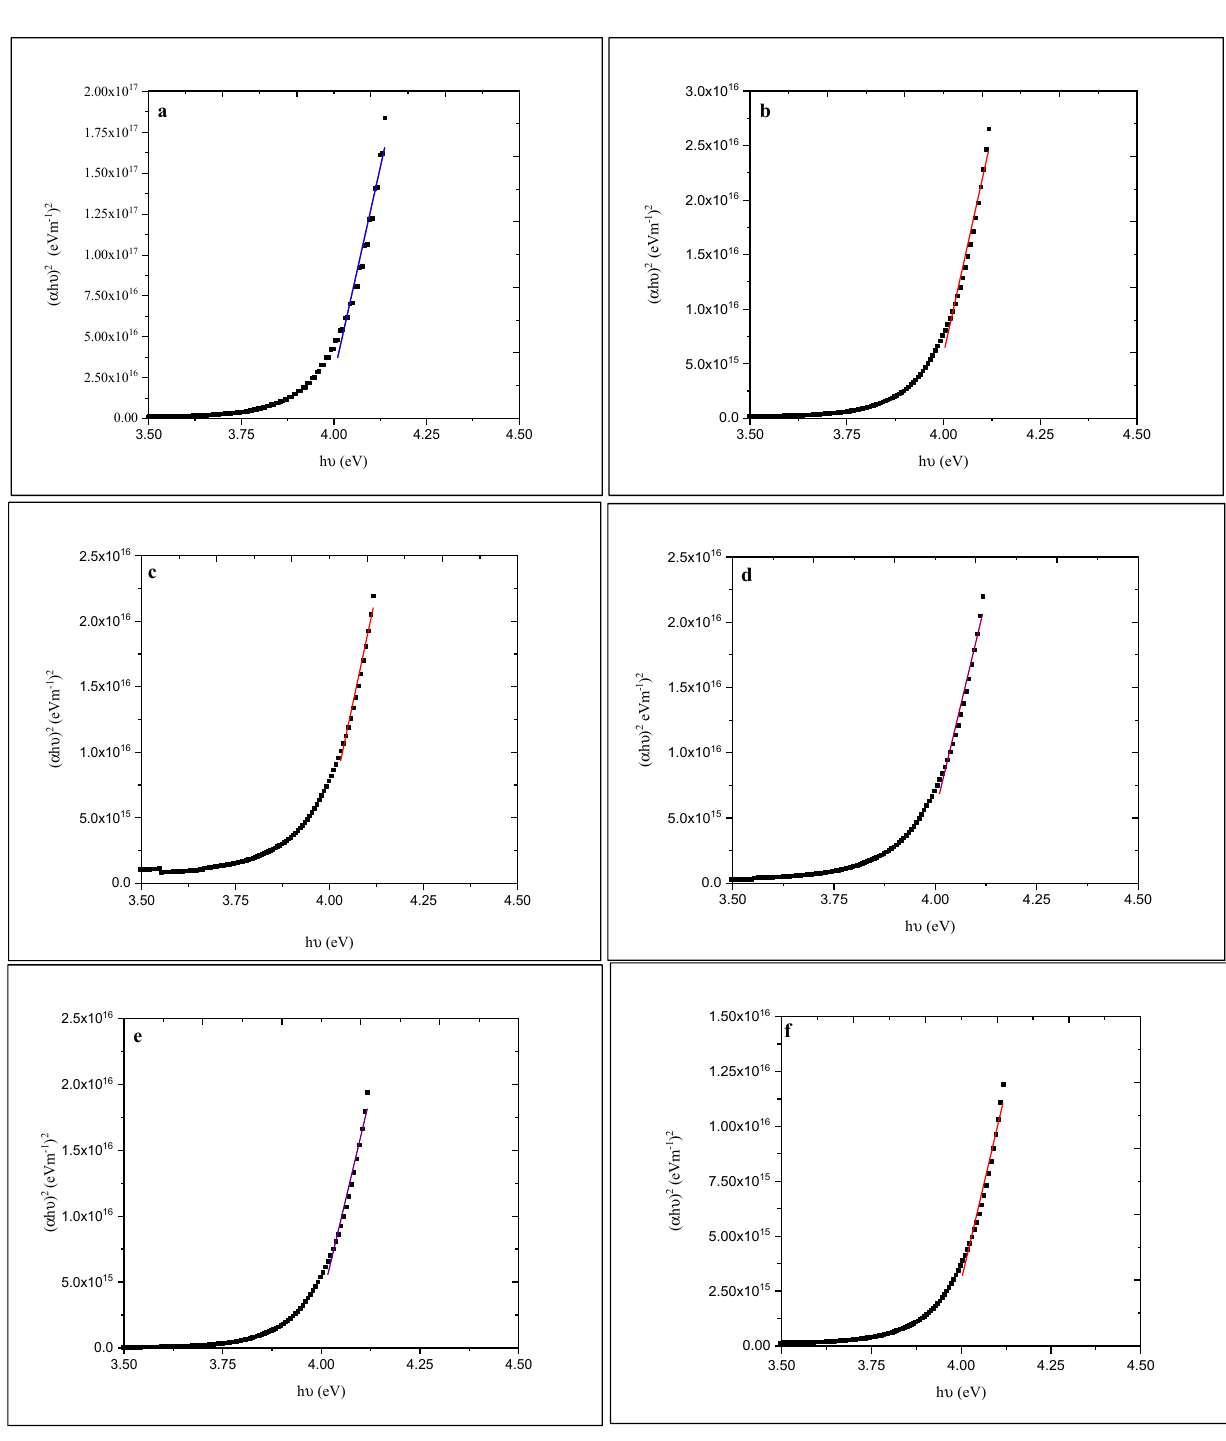
Figure 7. Plots of ( α h υ ) 2 versus h υ for ( a )-as-deposited and annealed (at ( b ) 100, ( c ) 150, ( d ) 200, ( e ) 250, and ( f ) 300 °C) ZnS films.